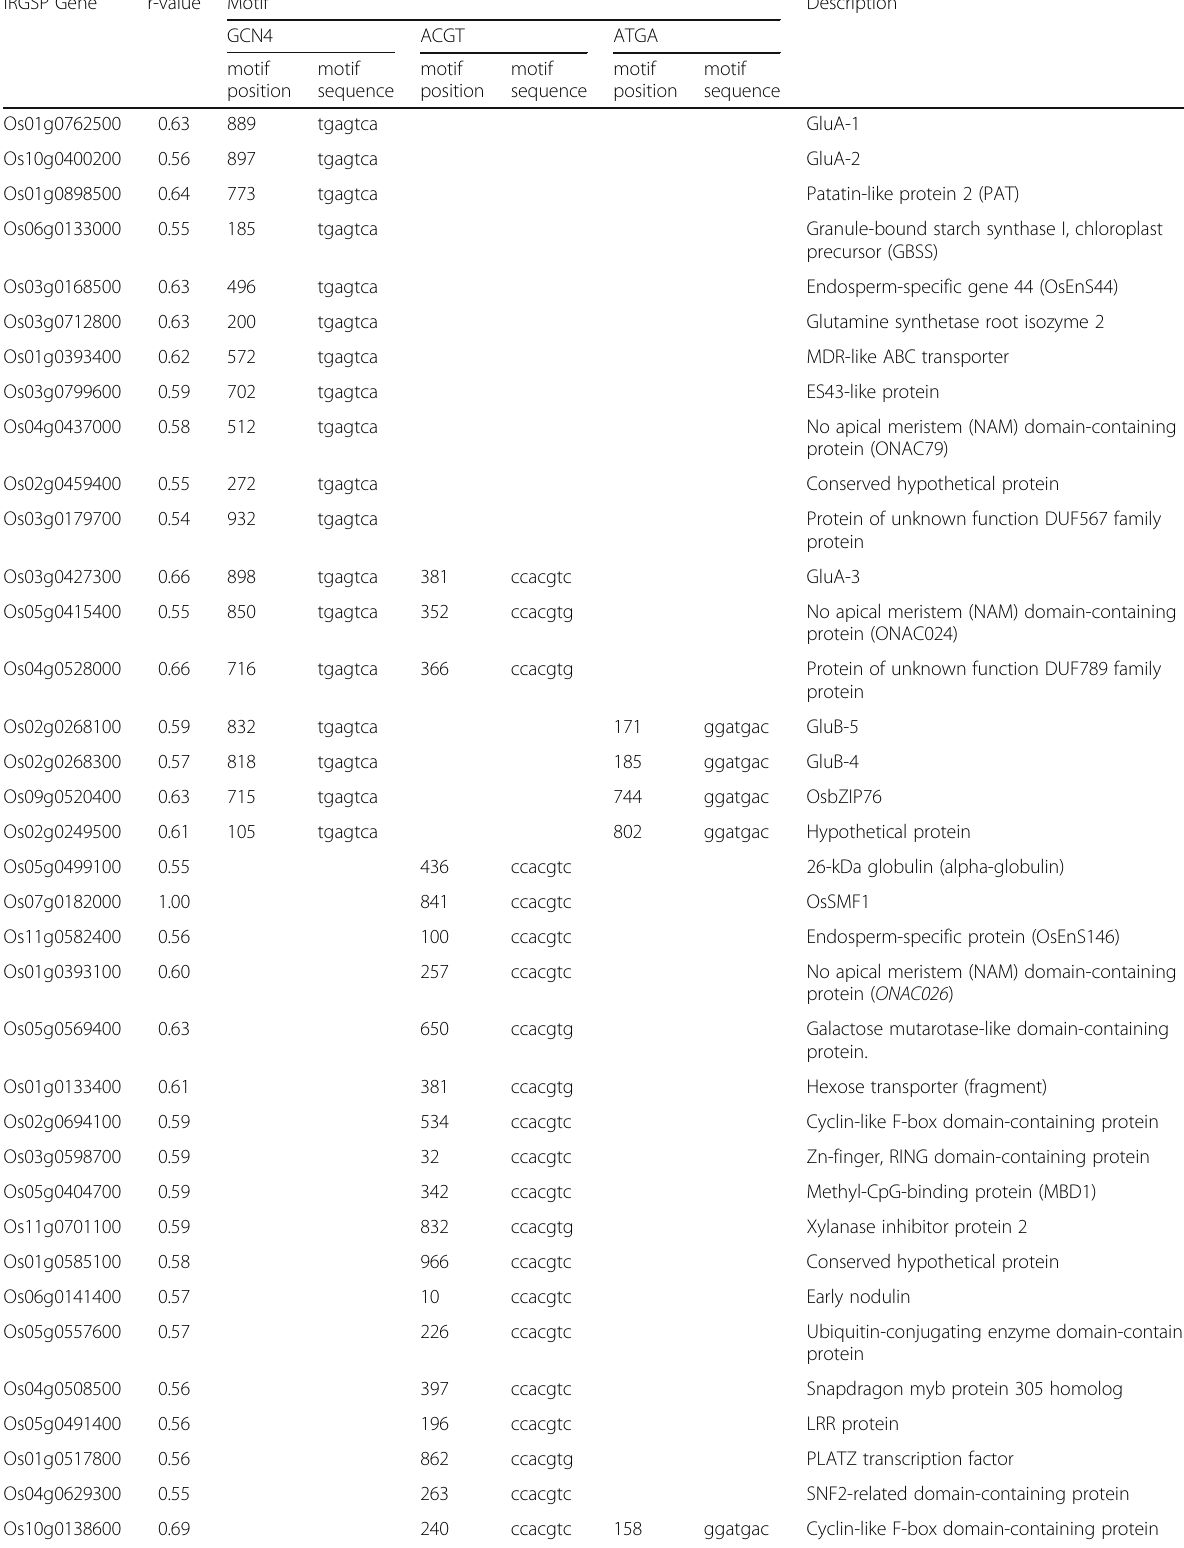
Table 1 Candidate OsSMF1 target genes, the binding motifs and RAN analysis and microarray expression data IRGSP